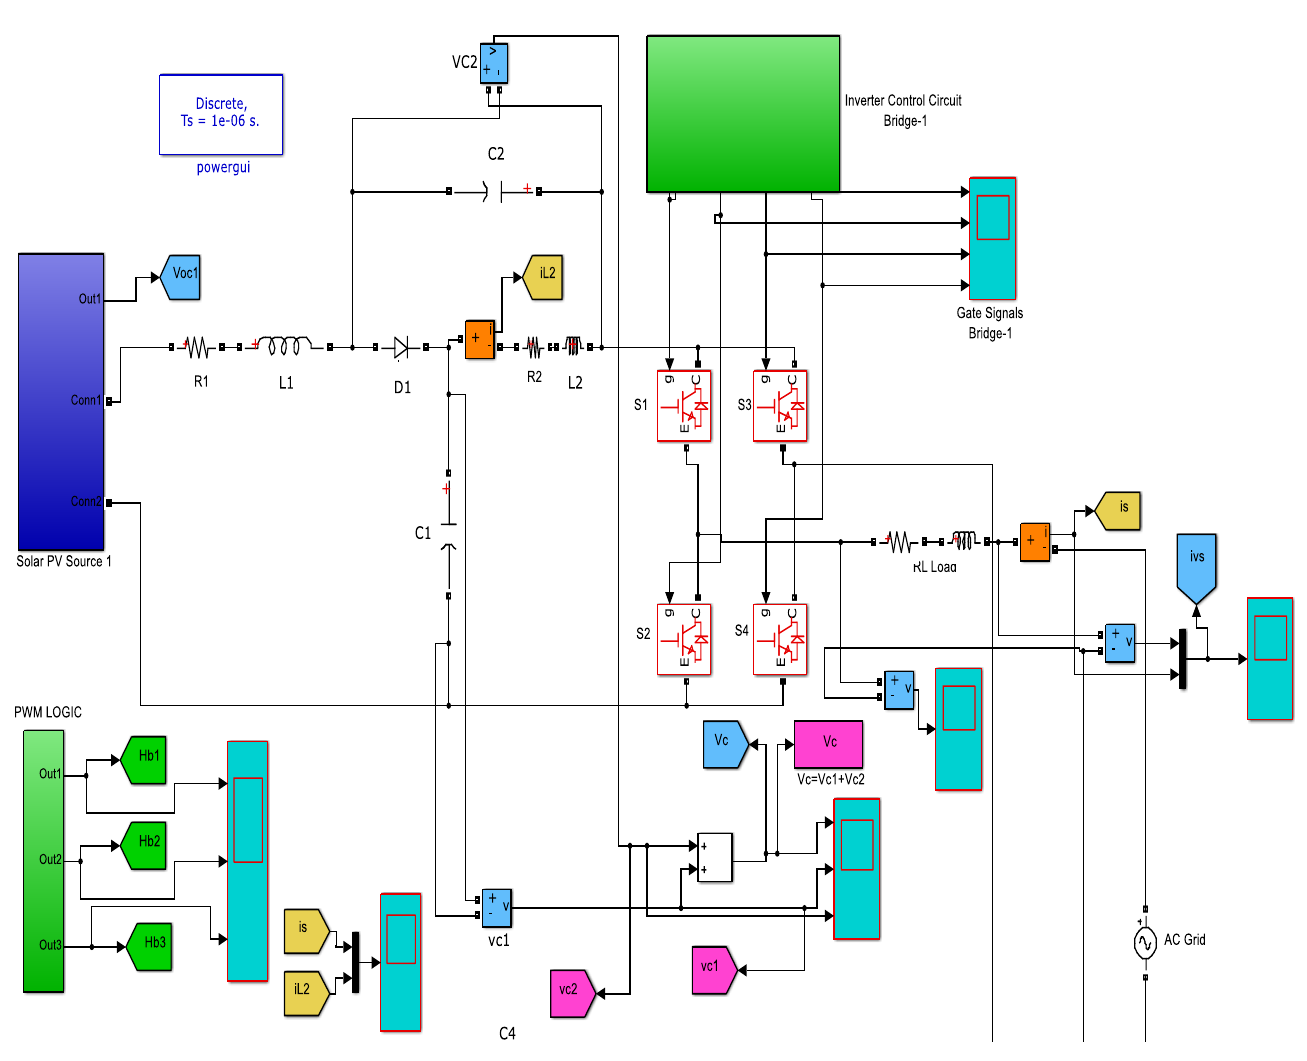
Figure 22. An H-bridge PV-powered qZS CMLI modeled in Simulink .